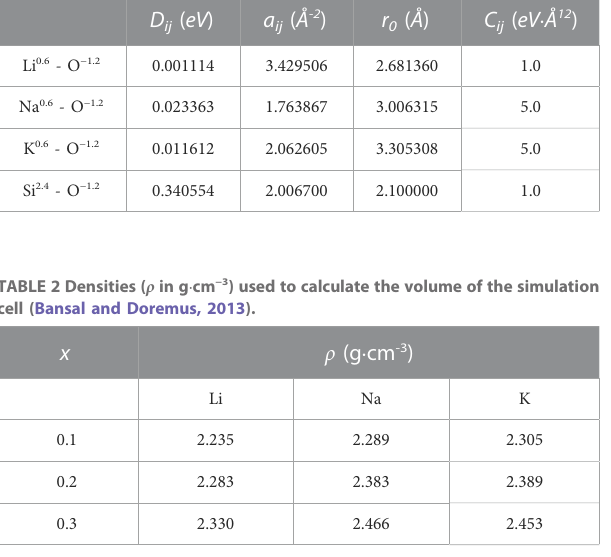
TABLE 1 Interatomic potential parameters used in alkali silicates derived by Pedone et al. (2006). D eV ) ij (